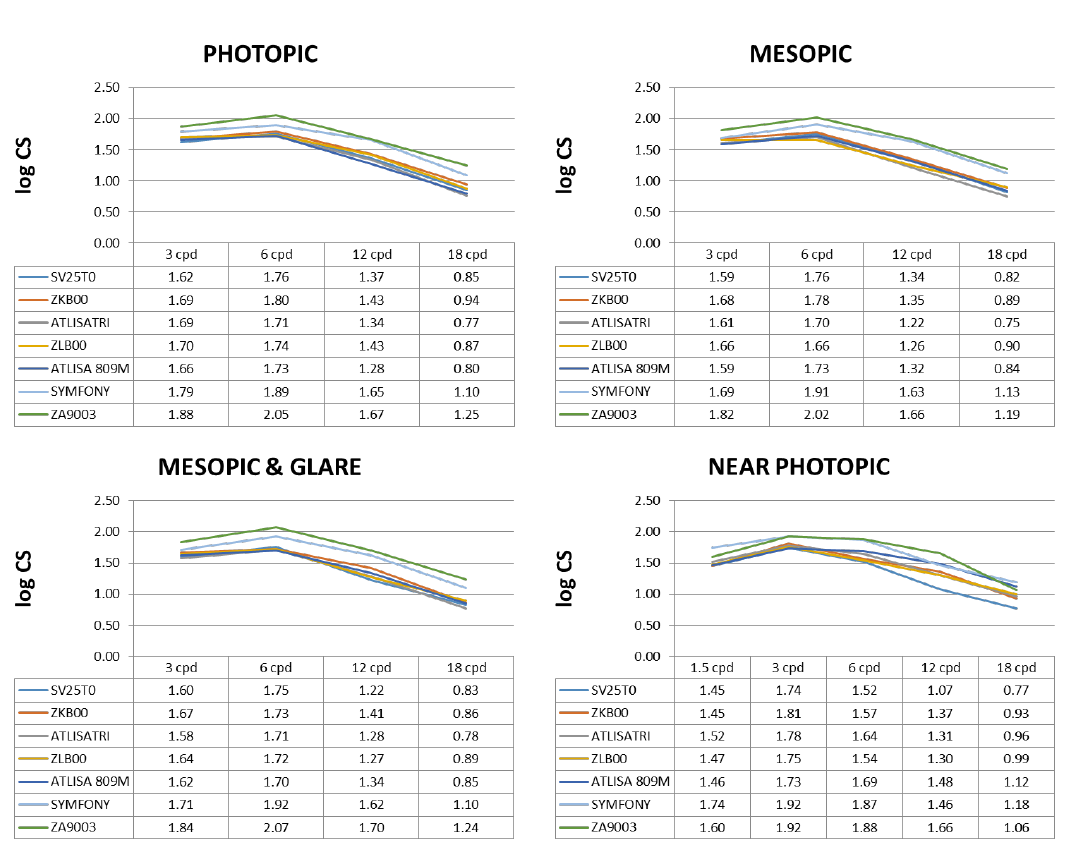
Figure 1. Postoperative binocular corrected distance mean log contrast sensitivity (CS) in photopic, mesopic, mesopic with glare and near photopic conditions.